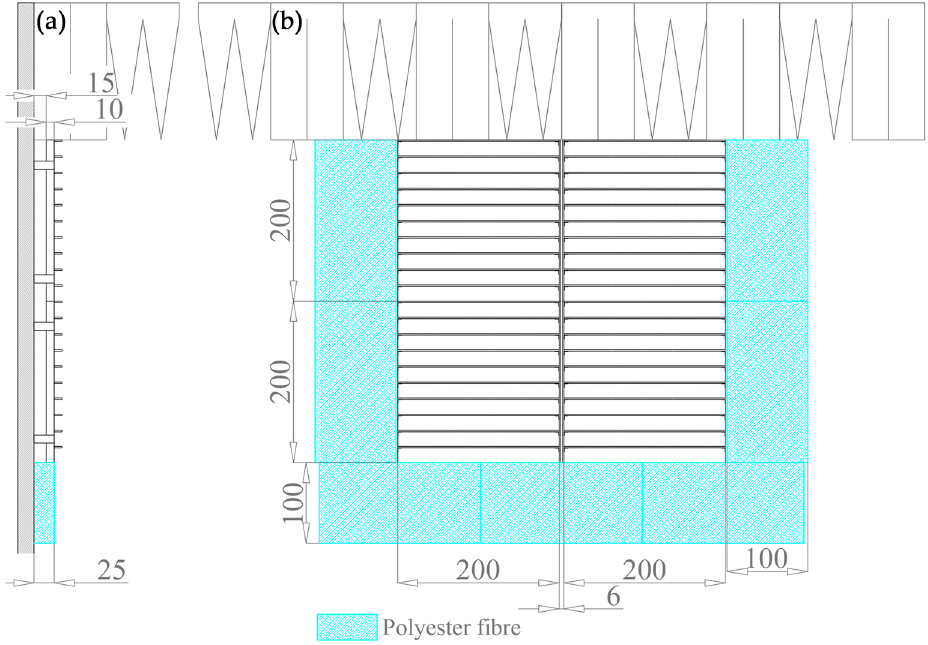
Figure 1. Side ( a ) and plan ( b ) views of the model of the shading devices in the semi-anechoic chamber. Dimensions are expressed in cm.